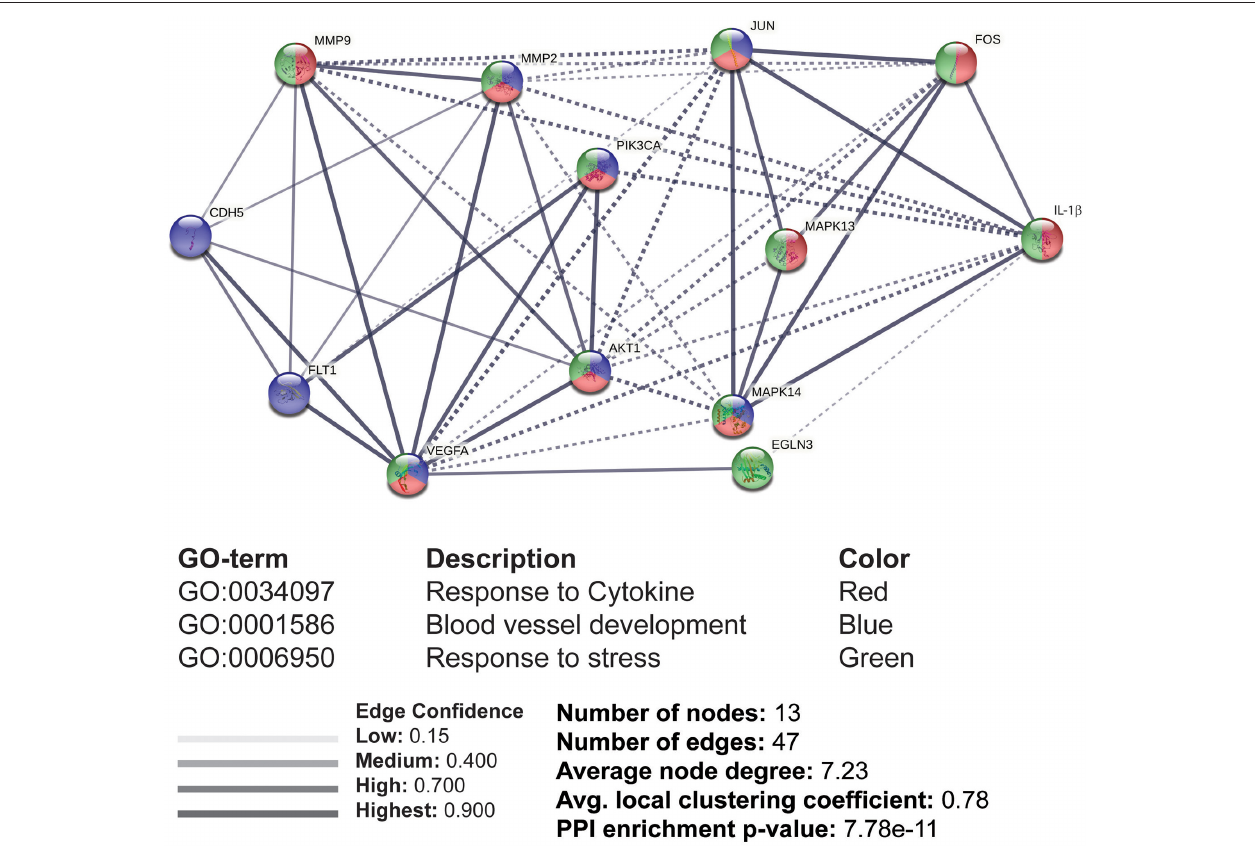
FIGURE 6 | The interacting molecules stimulated by IL-1 β through protein-protein interaction (PPI) network and Gene Ontology (GO) enrichment analysis. PPI and GO enrichment analysis of selected proteins were performed via the STRING online tool. Dashed lines represent the interaction between different clusters, while solid lines represent the interacting molecules within the same cluster. Colors (red, blue, and green) were provided to classify the concerning biological processes, including responses to cytokines, blood vessel development, and response to